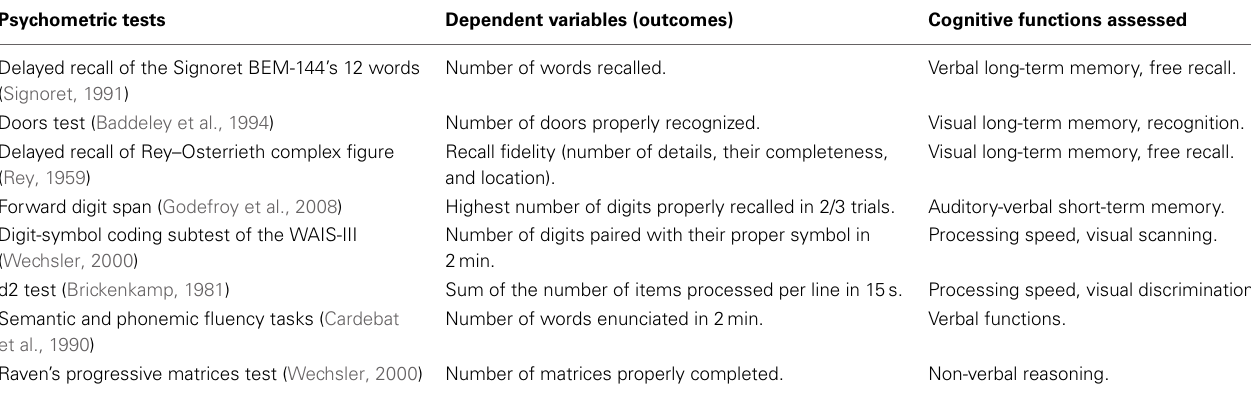
Table 2 | List of the tests used, the cognitive functions they assess, and the scores